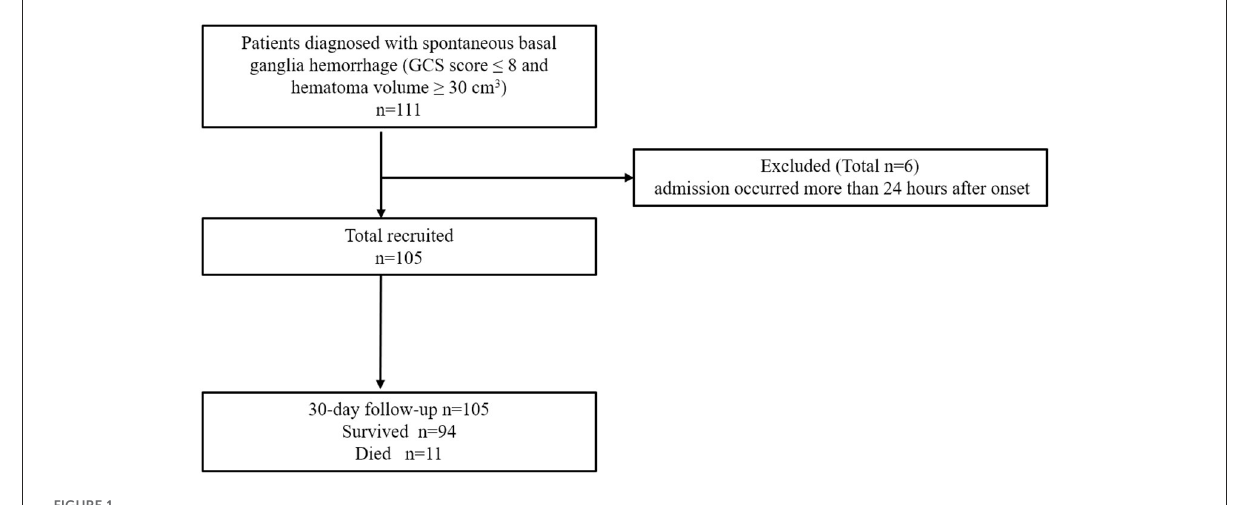
FIGURE1 Patient selection flow chart. GCS, Glasgow coma